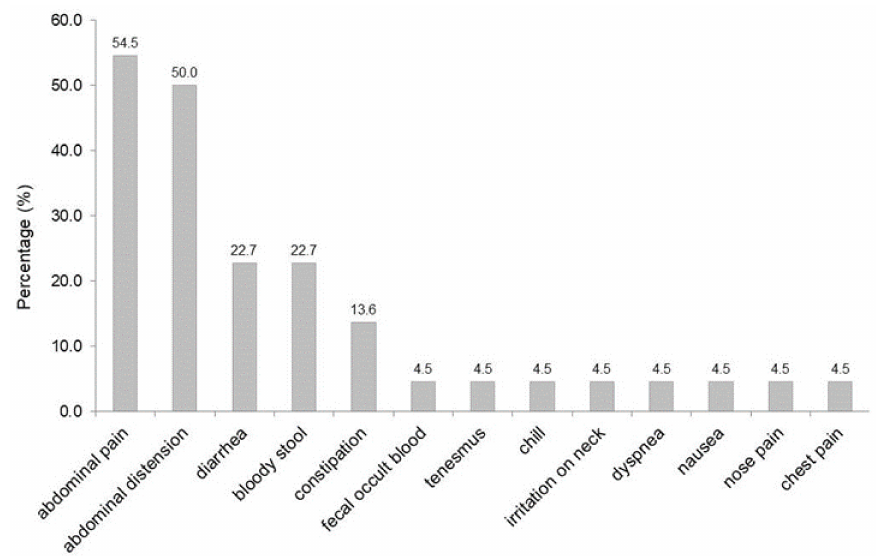
Figure 2. Overview of the symptoms of α GIs-induced PI. Legend: abdominal pain and distention were the most common symptoms, followed by diarrhea and bloody stool.